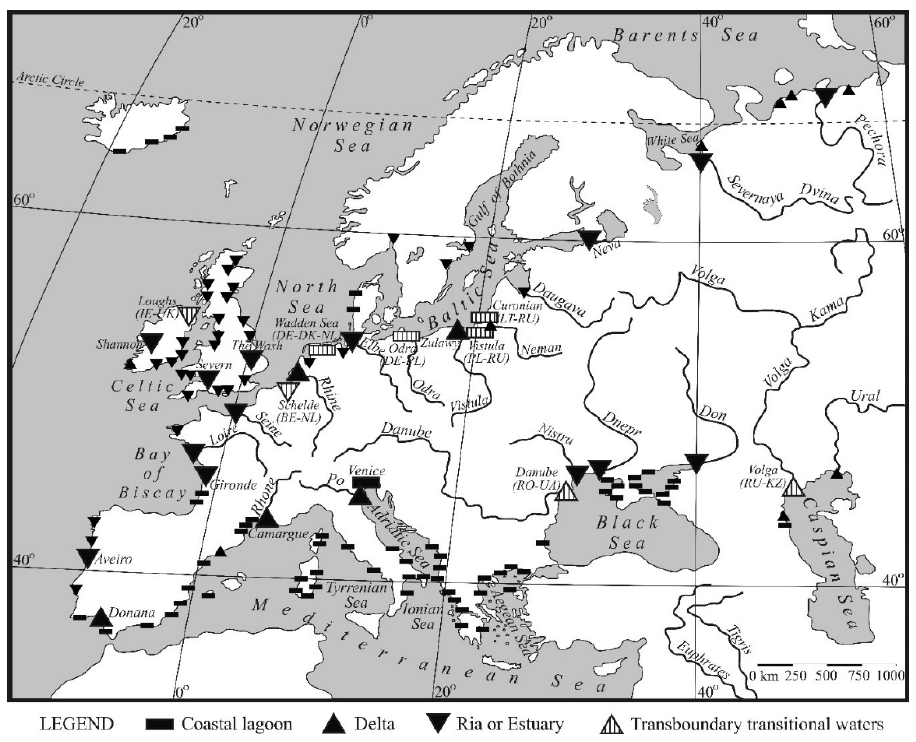
Figure 1. Generalization of major transitional water types in Europe